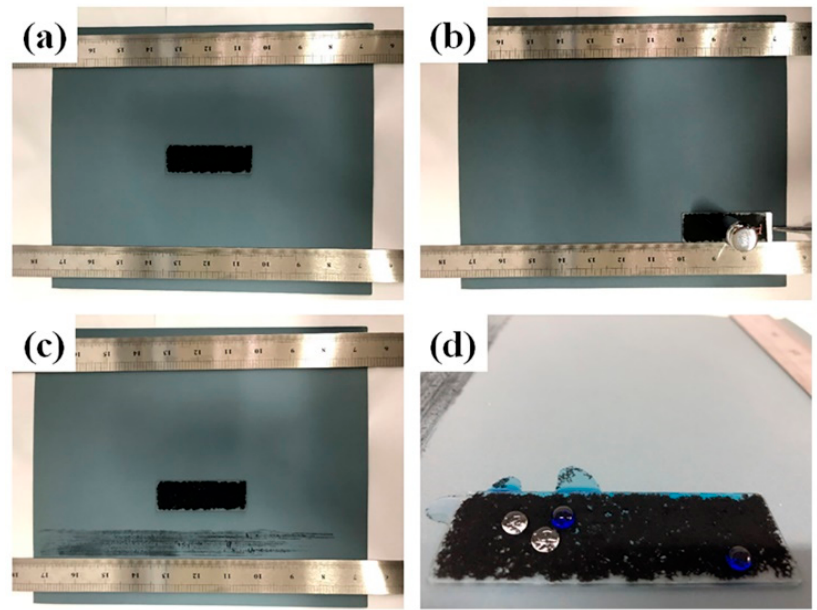
Figure 7. The experimental pictures of sandpaper-abrasion, the superhydrophobic composite coating: ( a ) test preparation; ( b ) under a weight at 100 g was placed face-down to sandpaper; ( c ) after the test; ( d ) the pictures of water drops sitting on the tested composite coatings. Blue water drops were dyed by methylene blue.